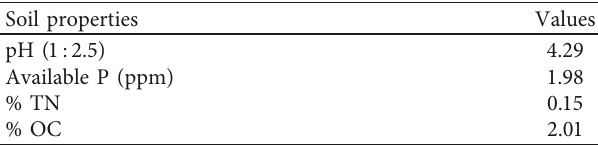
Figure 1: Map of Ethiopia showing the study area. Table 1: Soil chemical properties ( initial